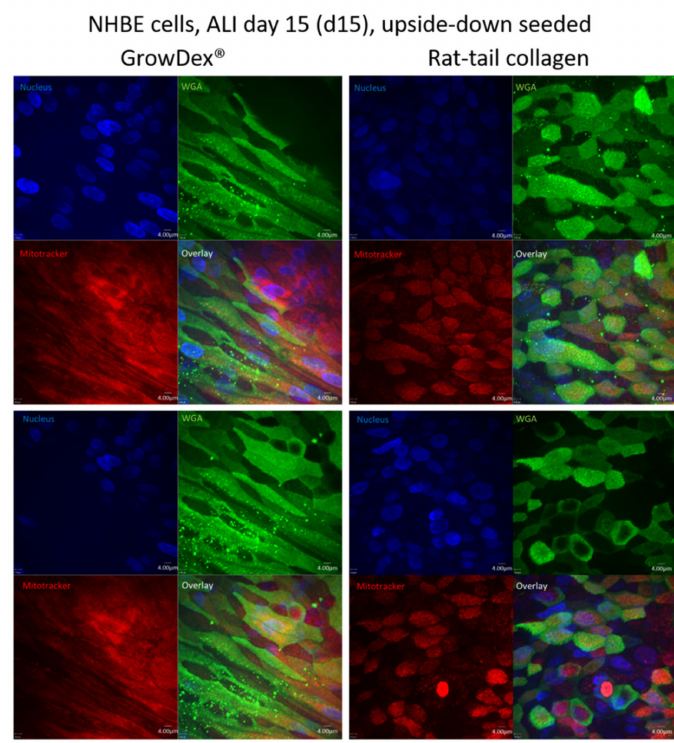
Figure 2. NHBE cells, day 15 (d15) in air-liquid interphase (ALI) and seeded upside-down. Left panel: cells grown on the animal-free, birch-based hydrogel. Right panel: cells grown on rat tail collagen-coated membranes. Images show faster proliferation, due to more cell layers and an increased cell number when the hydrogel was applied. Nuclei were stained using Höchst (blue), cilia using wheat germ agglutinin (green), mitochondria using mitotracker (red). An overlay is illustrated in the bottom right panels. Two representative images from at least 3 independent experiments are depicted for cells cultured upside-down in GrowDex ® or rat-tail collagen.